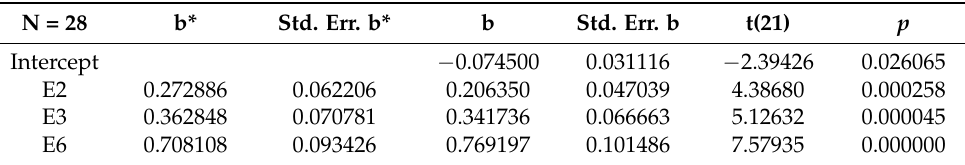
Table 9. Dependent variable E1 linear regression summary.